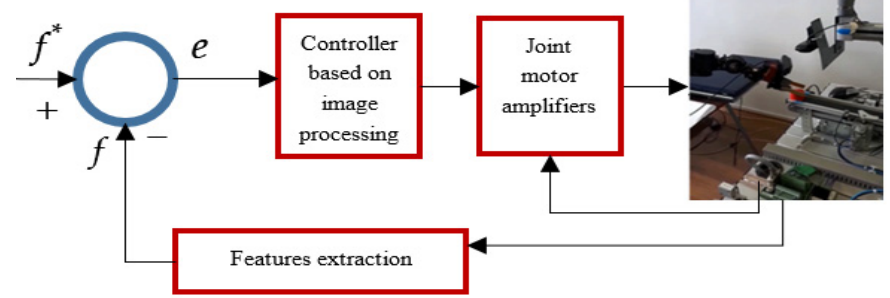
Figure 11. Eye in hand VSS based closed-loop control of the RM Cyton, [9]. @2019 IEEE